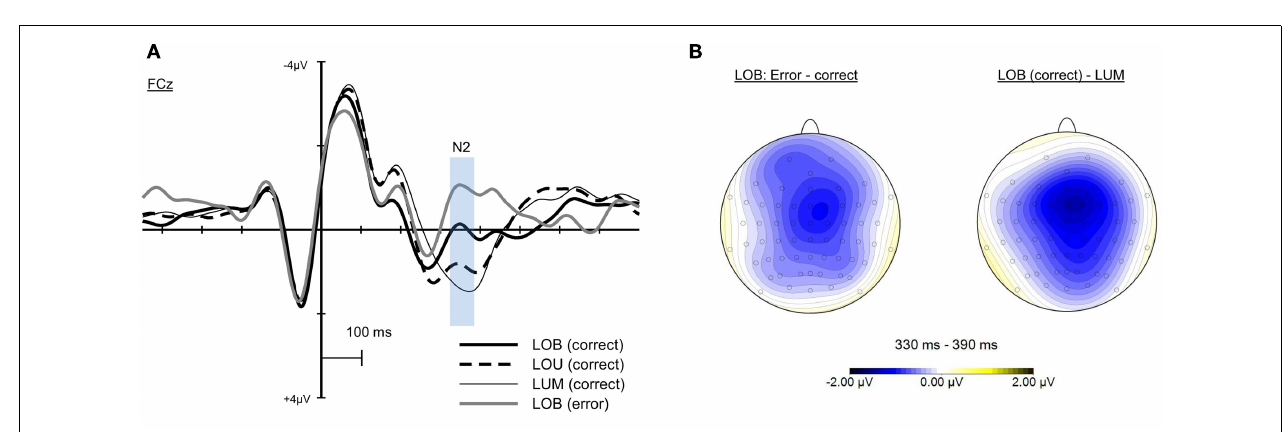
FIGURE 5 | Posterior asymmetries in the N1 and N2 time window for the LOB condition separately for erroneous (upper row) and correct change detection (lower row). Higher activation contralateral to the relevant luminance change compared to activation contralateral to the motion transient